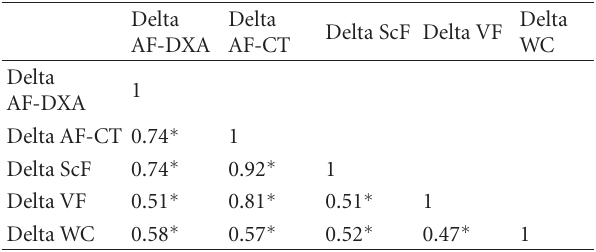
Table 4: Pearson’s correlations between changes in AF-DXA, AF- CT, ScF, VF, and